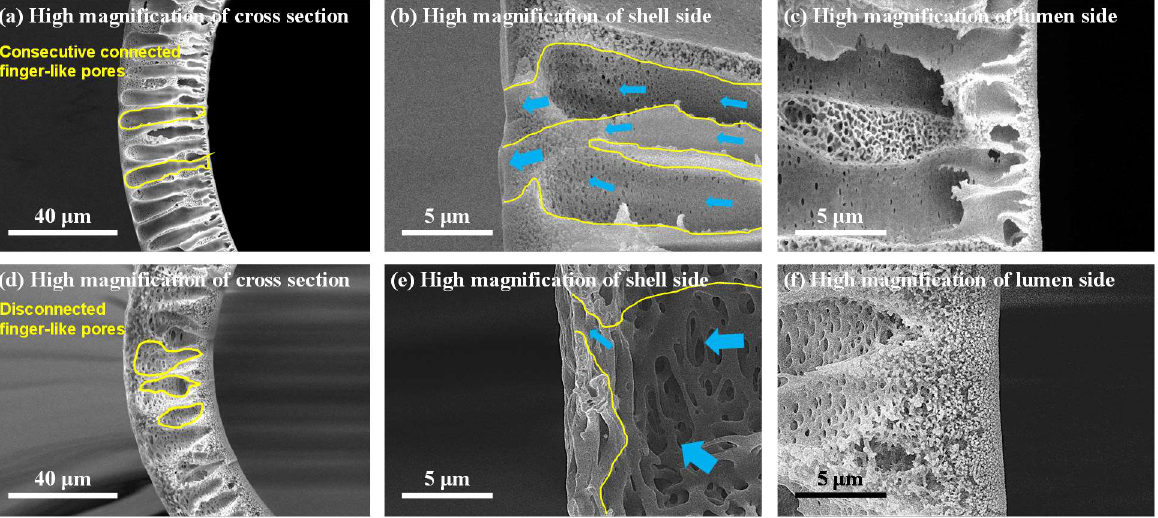
Figure 5. Confirmation of the formation of finger-like open pores connected with nanopores on the lumen side. ( a ). High magnification of DHF-520 cross-section, ( b ). High magnification of DHF-520 shell side, ( c ). High magnification of DHF-520 lumen side, ( d ). High magnification of CHF cross-section, ( e ). High magnification of CHF shell side, ( f ). High magnification of the CHF lumen side.